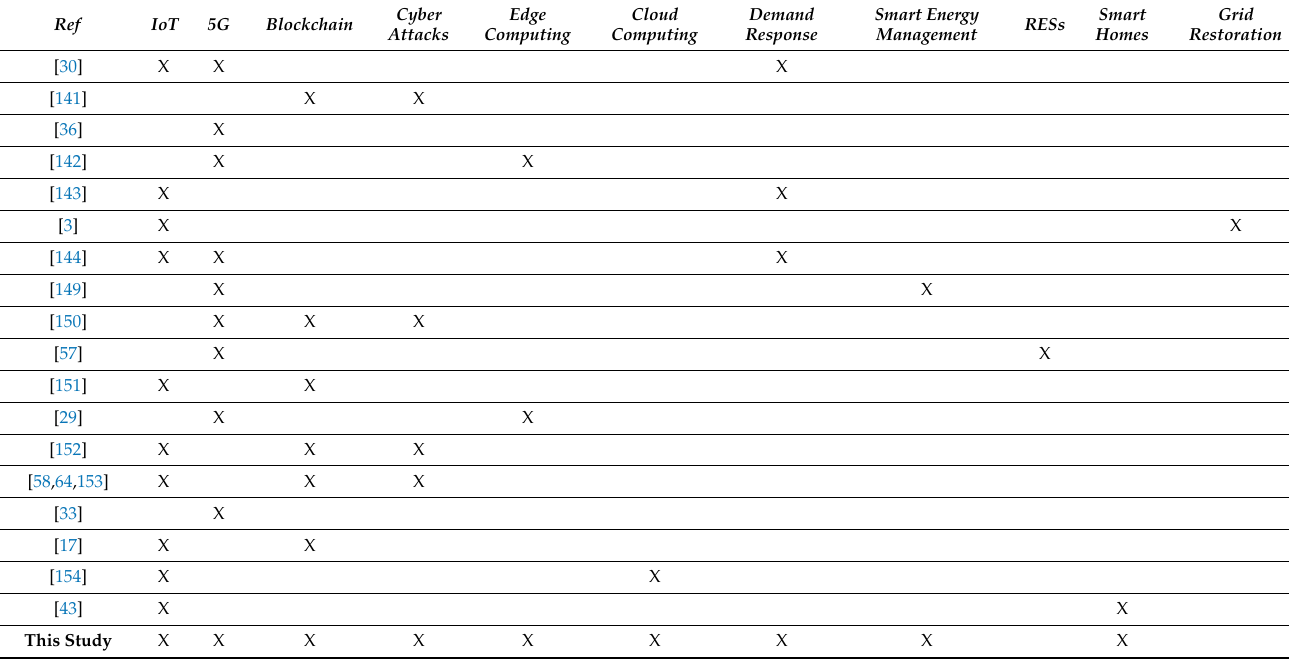
Table A1. Novel characteristics of this study as compared with the existing